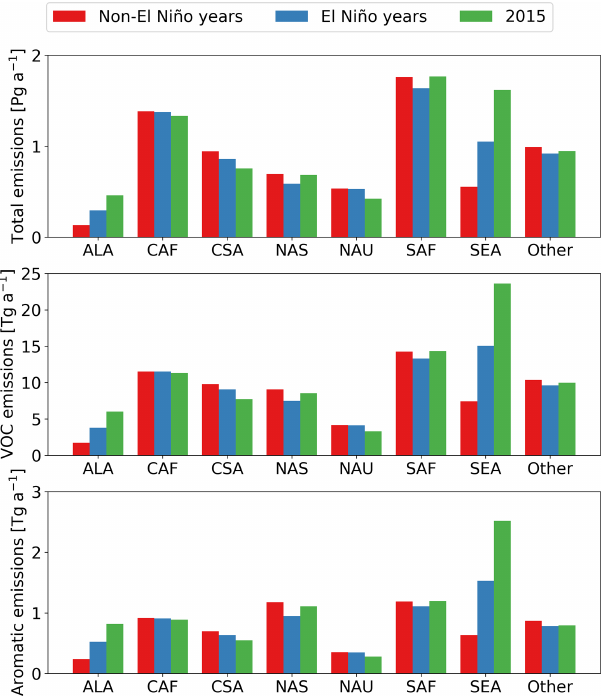
Figure 4. HCN comparison between IASI, REF, and FIR. (a) Mean global observed IASI HCN columns for September to November. (b) Mean global HCN column comparison between REF and IASI for September to November. (c) Mean global HCN column compar- ison between FIR and IASI for September to